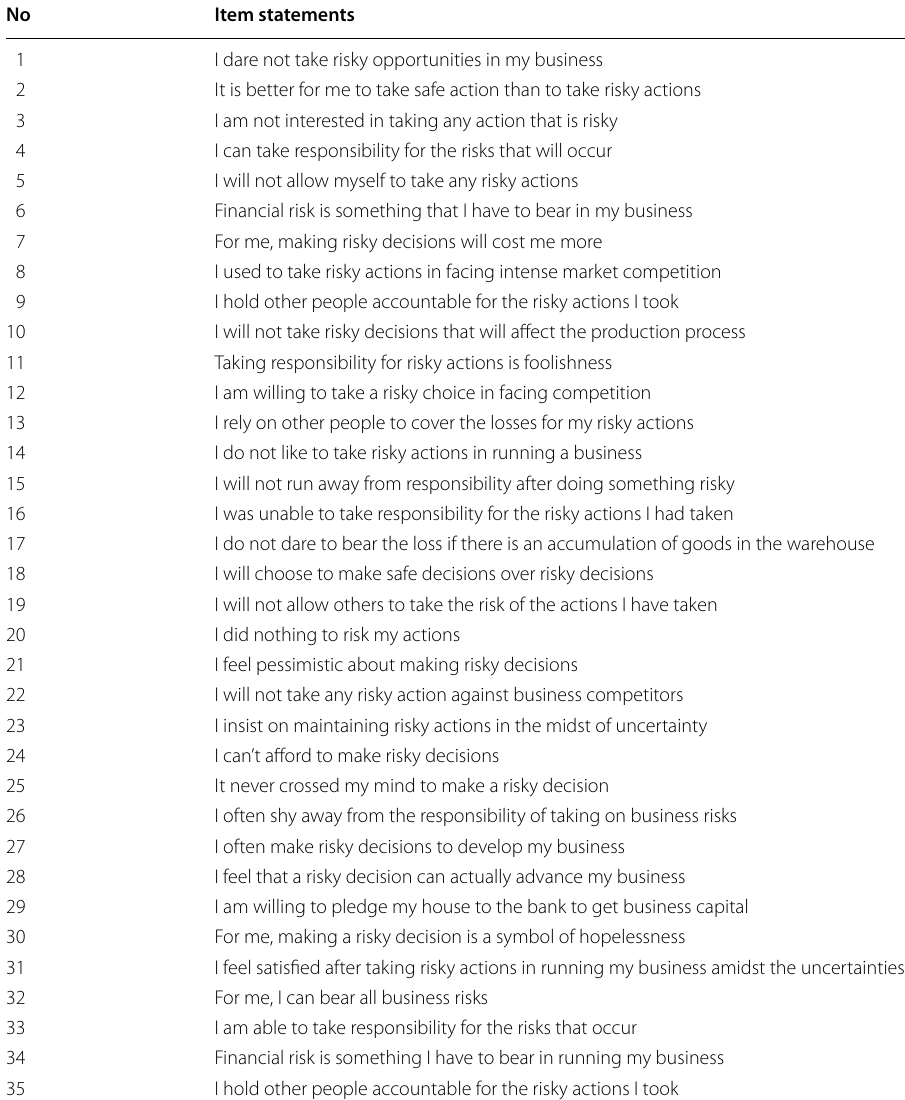
Table 2 Items measuring risk taking behavior (Riyanti,